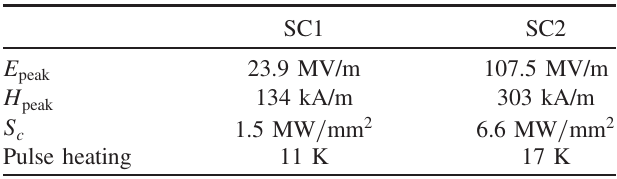
TABLE V. Peak surface parameters of storage cavities during the high-power test.